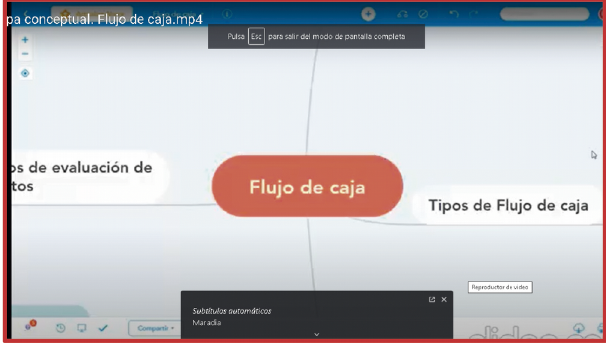
Figure 15. Cash Flow Conceptual